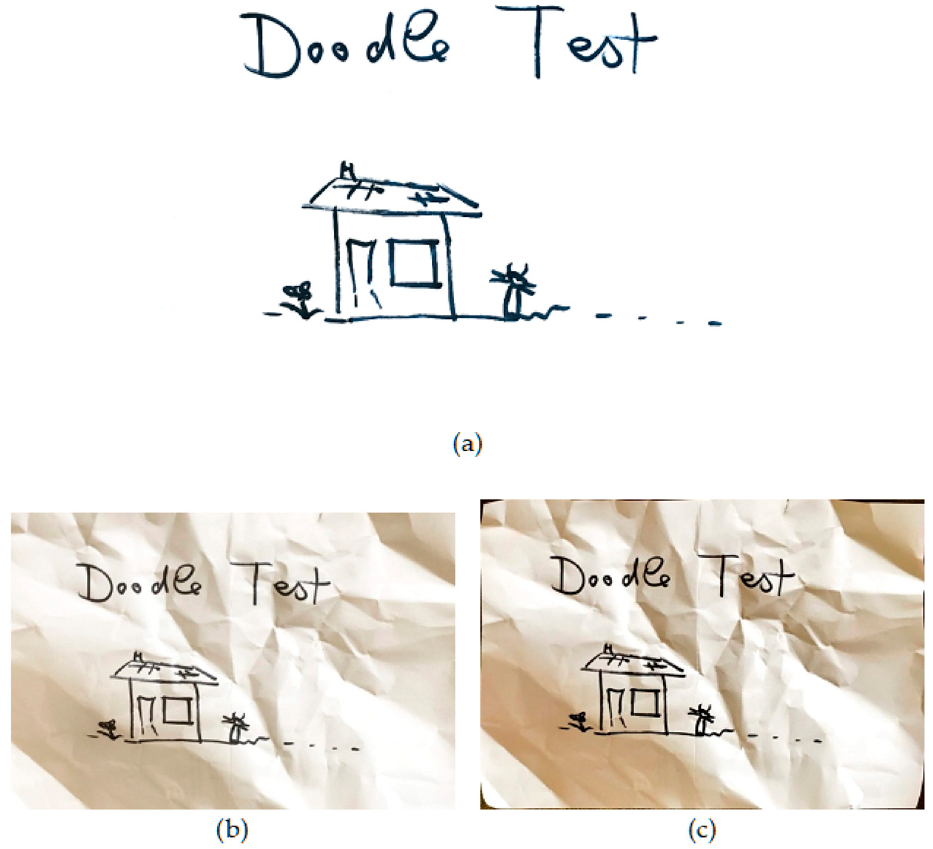
Figure 5. Sample results from scans of content on crumpled paper. ( a ) CleanPage; ( b ) Google PhotoScan; ( c ) Microsoft Office Lens.